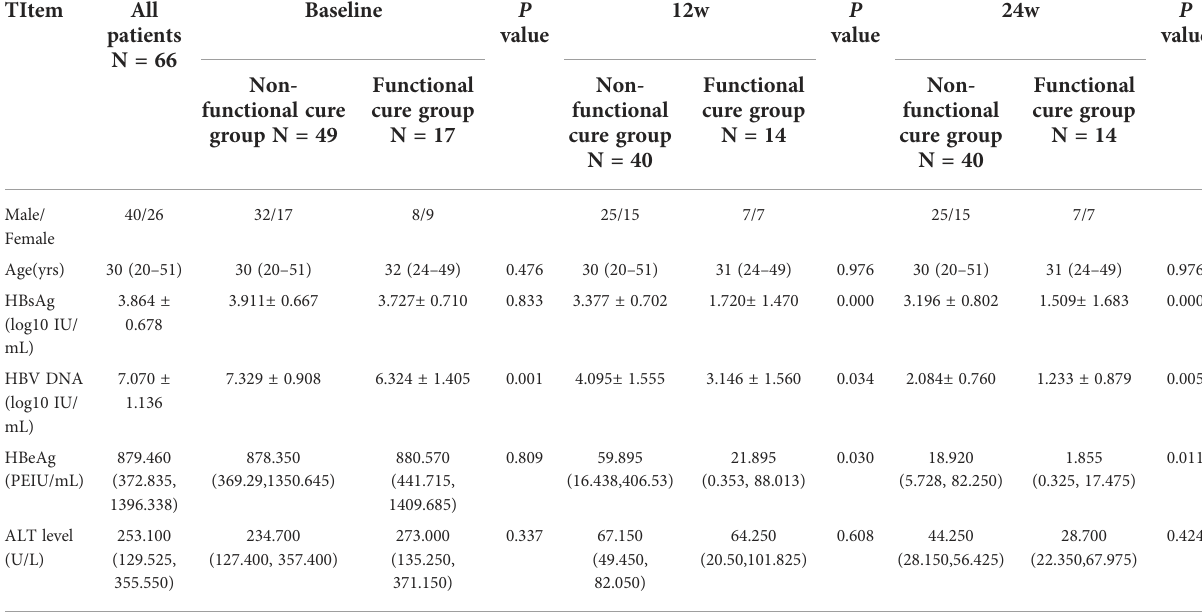
TABLE 1 Comparison of clinical characteristics. TItem All